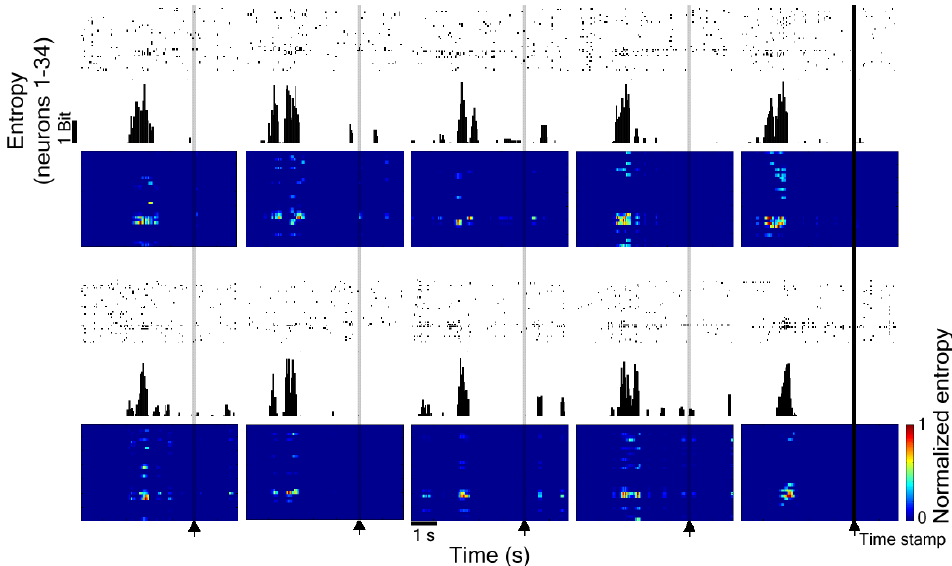
Fig. 7. Neuronal ensemble sparse coding during working memory task. The tripping time by infrared in Y-maze is indicated by an arrow. The rasters indicate the timestamps of spikes. Histogram of sparse reconstructed neuronal population ¯ring entropy. Dynamic mappings present results of neuronal ensemble sparse coding. Ten trials have been shown and each column represents one trial.